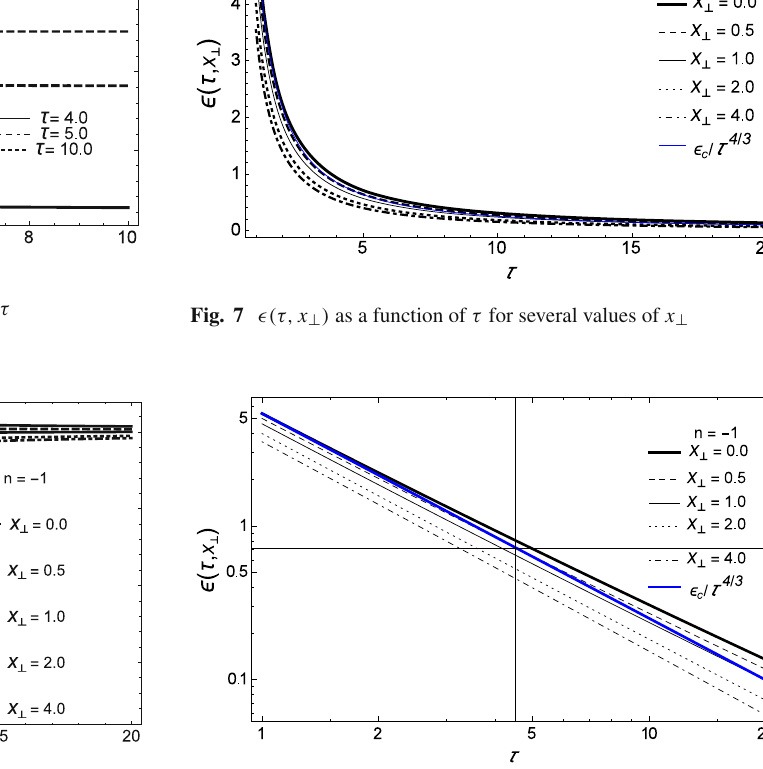
Fig. 6 (cid:5) 1 as a function of τ for different values of x ⊥